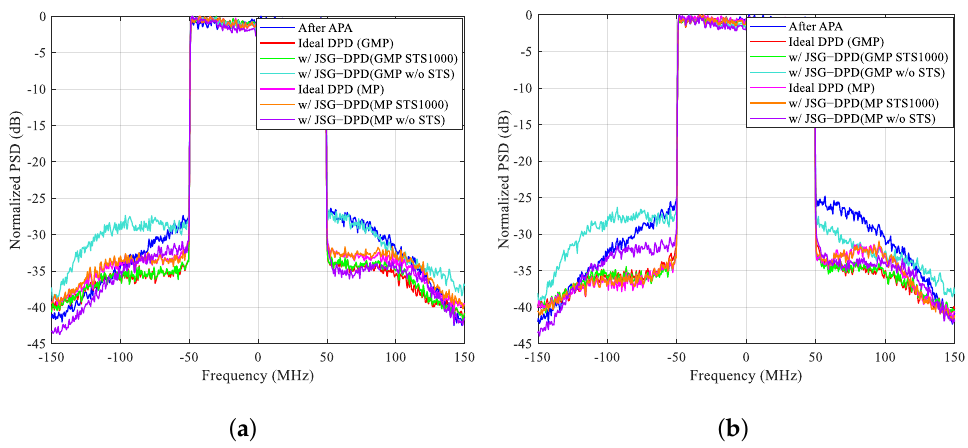
Figure 14. Measured normalized PSD with different methods for different input power levels from VSG: ( a ) P in : − 25 dBm; ( b ) P in : − 24